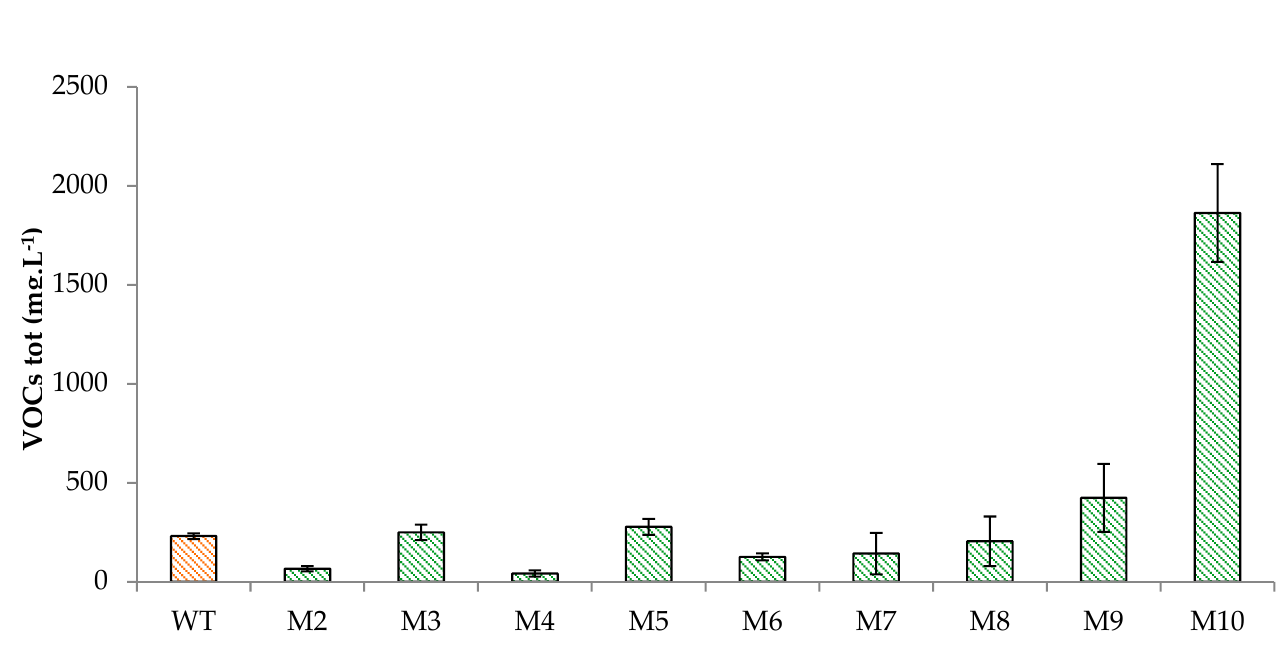
Figure 3. Total VOCs determined by gas chromatography coupled to mass spectrum detector (HS-SPME-GC/MS) analysis in the wild type and the 9 ILV - isolated mutants. Abbreviations: WT, wild-type of S. suaveolens ; M2, M3, M4, M5, M6, M7, M8, M9, M10, and ILV - mutants of S. suaveolens produced by UV mutagenesis. Data shown are the mean ± SD of three independent cultures. Table 1. Total number of volatile organic compounds (VOCs) produced by S. suaveolens wild type and ILV- mutants. WT M2 M3 M4 M5